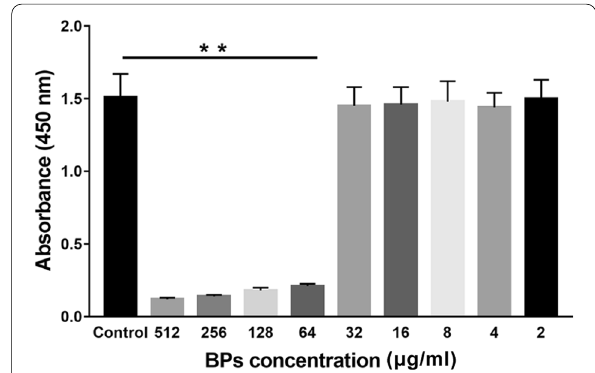
Fig. 3 The cytotoxicity of BPs. Cells were treated with BPs (0, 2, 4, 8, 16, 32, 64,128, 256, and 512 µg/ml) for 24 h, and EMSC viability was tested by cell counting kit (CCK-8) proliferation assay ( n 9). Data = were expressed as mean standard deviation (SD). ** p < 0.01. ±